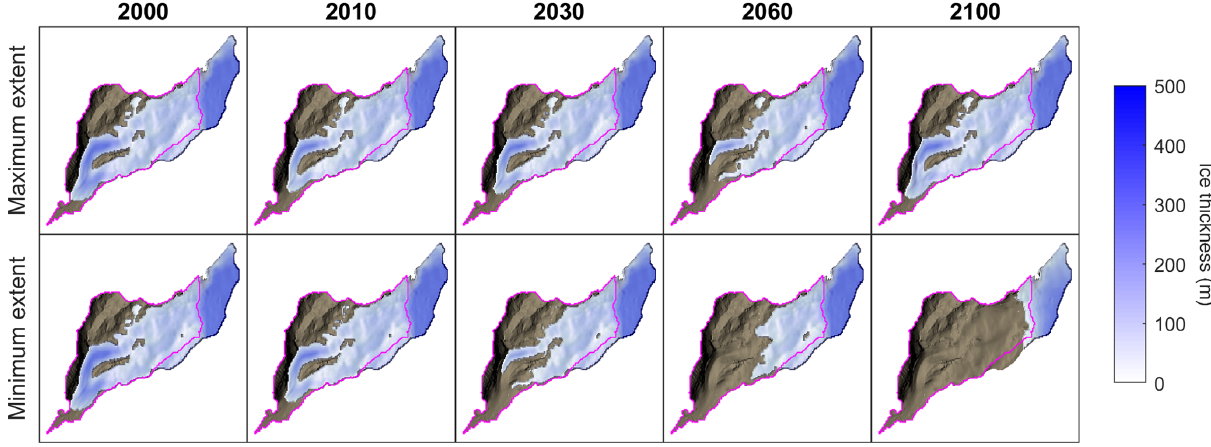
Figure 8. Simulated ice thickness between 2000 and 2100 based on simulations that projected the maximum (RCP4.5) and minimum (RCP8.5) ice coverage by 2100. Watershed outline shown in magenta.